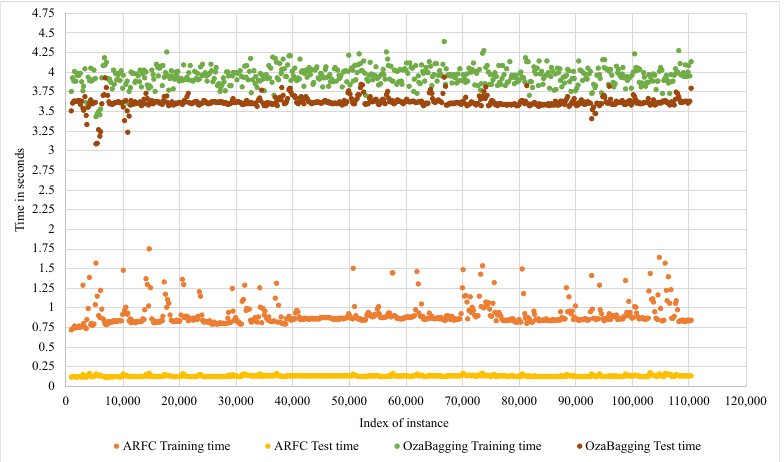
Figure 8. Comparison of Computational time costs of ARFC and OzaBagging in Master node.